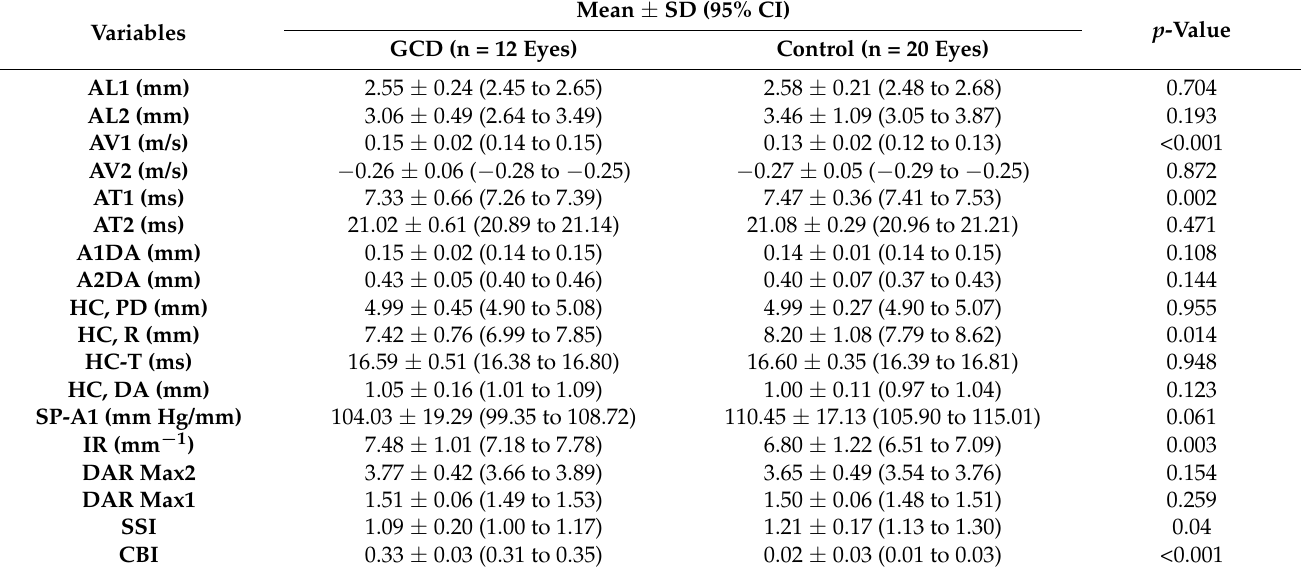
Table 2. Mean and SD of the corneal biomechanical parameters using the Corvis ST separately in the two groups with the central corneal thickness (CCT) and biomechanically corrected intraocular pressure (bIOP), with age as